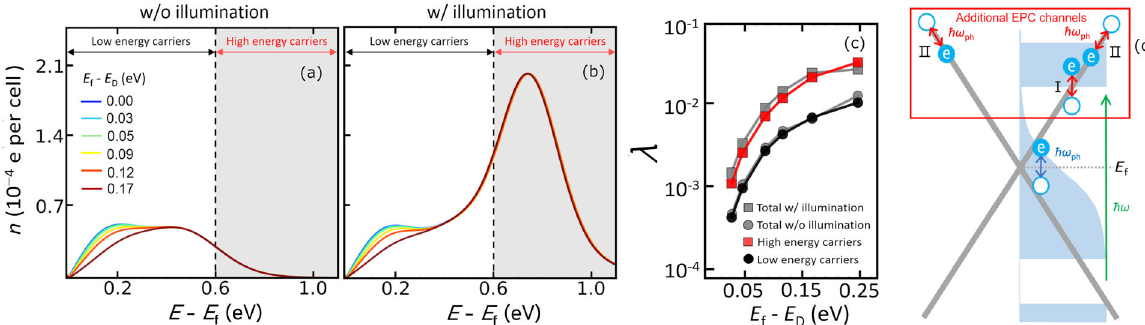
Fig. 3 Carrier resolved EPC in graphene. The energy distribution of EECs on π * band, n e ( E − E f ), without ( a ) and with ( b ) laser illumination at different doping concentrations represented by E f − E D . The low (high) energy carriers are excited by phonons (photons), which are labelled by black (red) arrows. c The λ contributed by low and high energy carriers as a function of doping concentration. d Schematic illustration showing the EPC channels in photoexcitation state. Regions with light blue shades are fi lled with electrons. The deep blue arrow shows the phonon-assisted interband transitions. Without illumination, electrons have the interband transitions by interacting with the phonons, which provide the conventional EPC channels. The green arrow shows the photoexcitation. The red rectangle and red arrows label the additional EPC channels originate from the phonon-assisted intraband transitions (PAITs) of carriers out of equilibrium, which include the electronic broadening effects (process I) and scattering between different k points (process